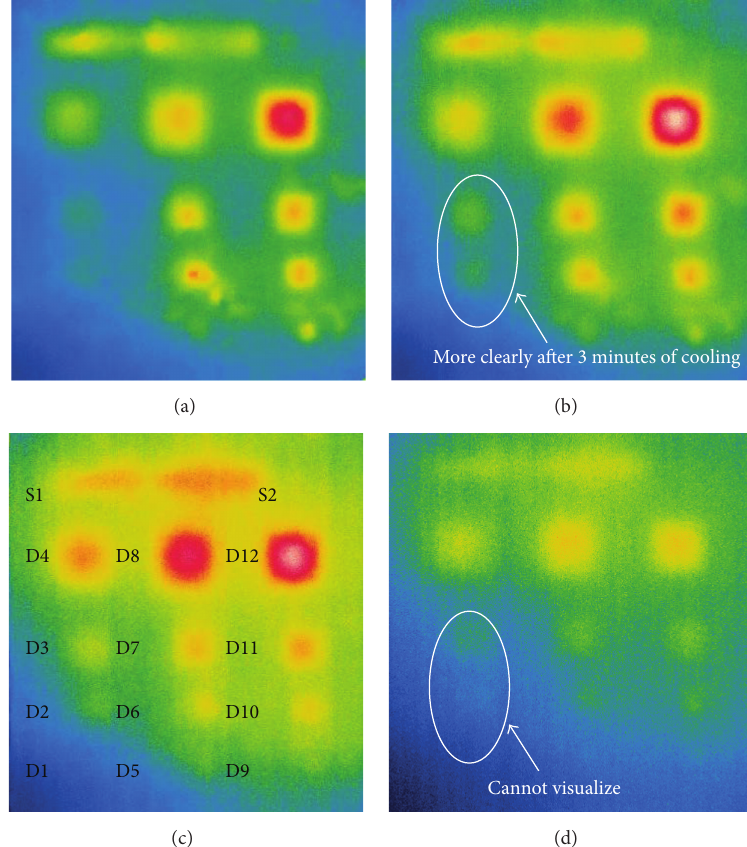
Figure 9: IR thermal images from the cooling period at (a) 0, (b) 3, (c) 12, and (d) 24 minutes for the 20-minute heating cycle.